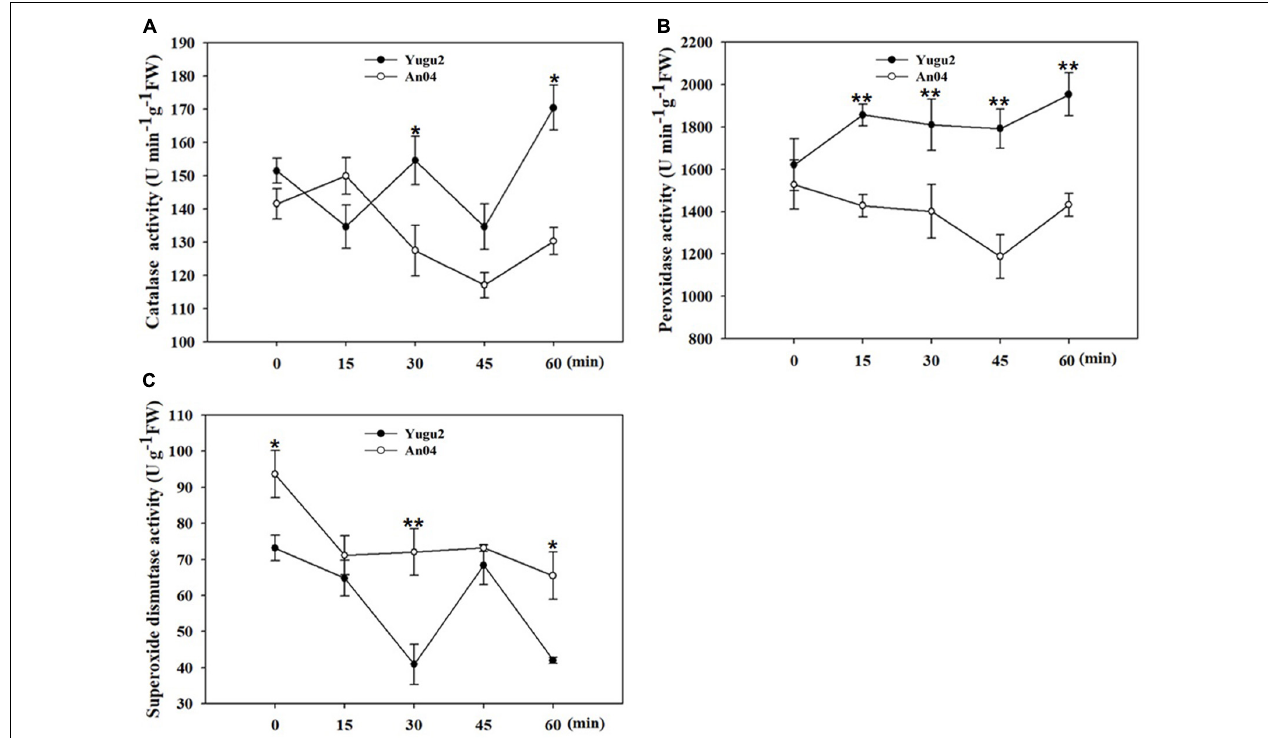
FIGURE 1 | Measurement of antioxidant enzymes activities of catalase (CAT) (A) , peroxidase (POD) (B) , and superoxide dismutase (SOD) (C) . Error bars indicate ± SE of at least three biological repeats. Student’s t -test were carried out to analyze significant differences between two varieties, **indicates the p -value < 0.01 and *indicates the p -value < 0.05,